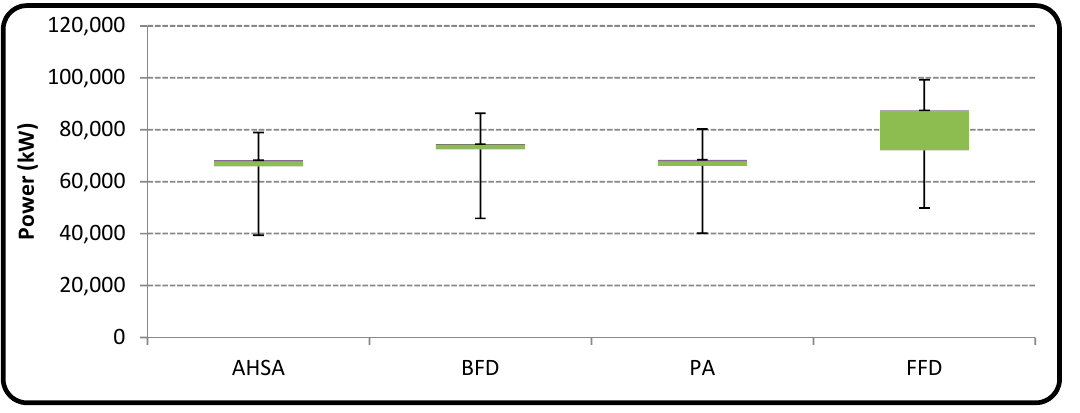
Figure 13. Power consumption.